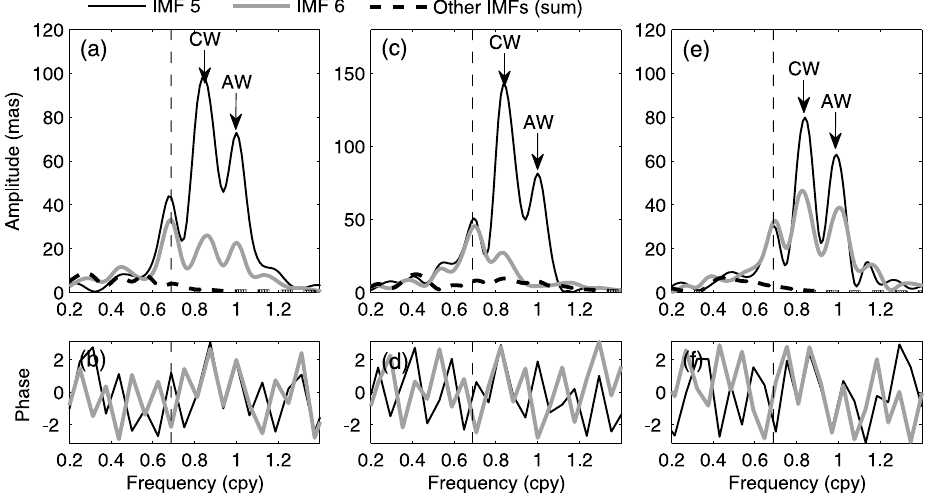
Figure 4. The amplitudes and phase spectra of the IMF 5 and IMF 6 and the sum of the other IMFs of the x -components of the three sub-series after using EEMD (a–f) for the 1962–1977, 1978–1994 and 1995–2013 series, respectively. The vertical dashed lines denote the possible spectral peaks for the